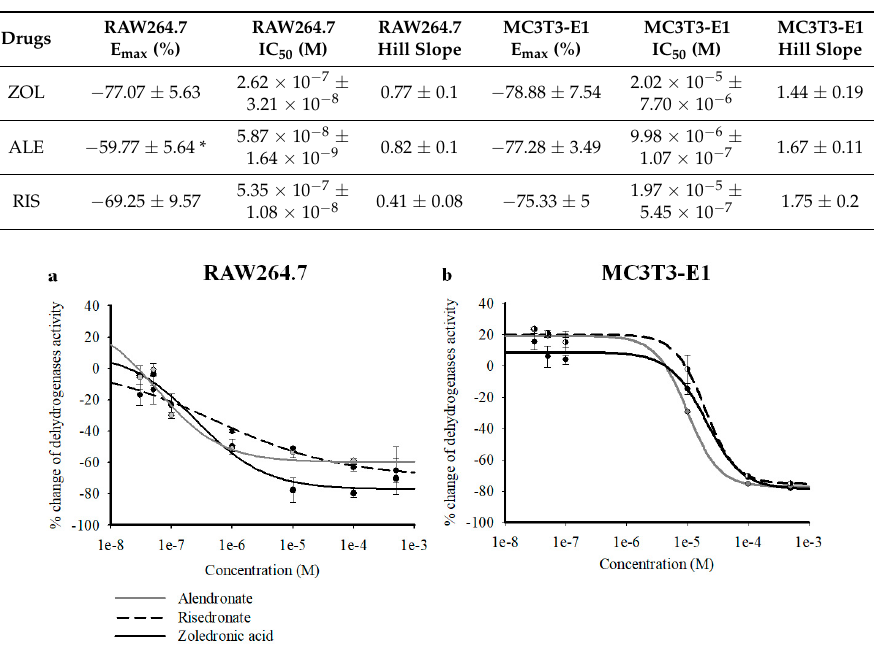
Table 1. Fitting parameters of the concentration–response relationships of percentage reduction of dehydrogenase activity vs. BP concentration in preosteoclast RAW264.7 and preosteoblast MC3T3-E1. Values are expressed as the mean ± SEM of at least three replicates, as evaluated by using SigmaPlot 10. Data significantly different vs ZOL data *.